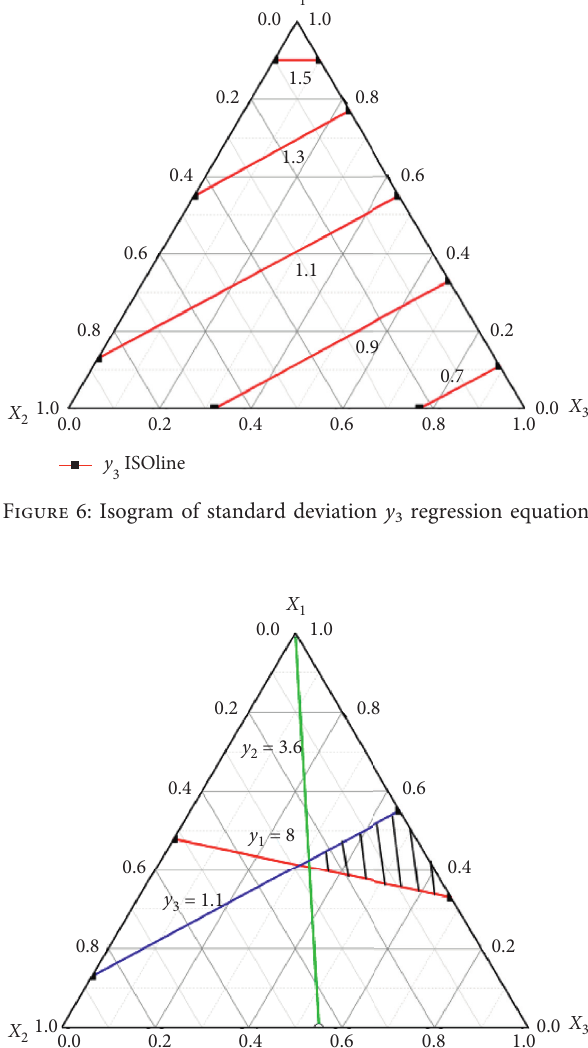
Figure 7: Optimal formulation region for synthesizing the three reaction variables y 1 , y 2 , and y 3